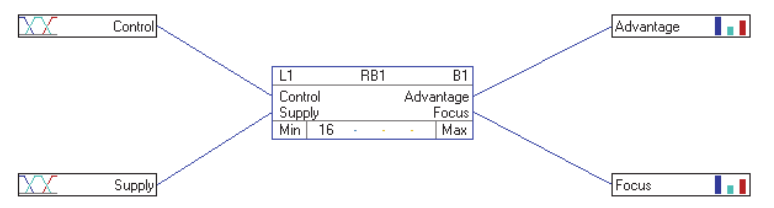
Fig. 2. Designed model in fuzzy TECH 8.4 software